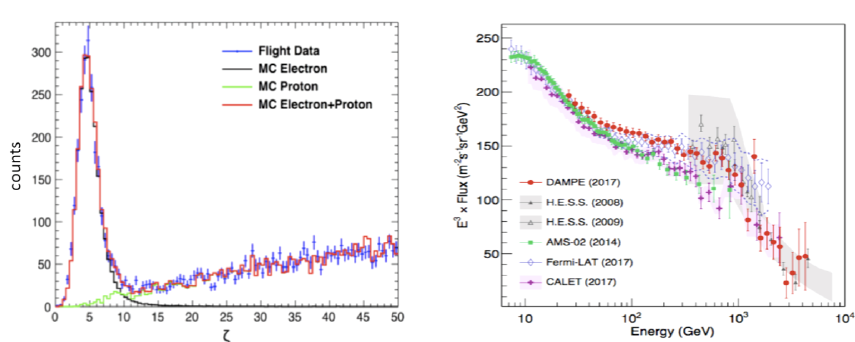
Figure 9. Left: Distribution of the ζ parameter (the cut ζ < 8 . 5 is applied to select the CRE sample). Right: electron and positron spectrum measured by di ff erent experiments (DAMPE: red dots, HESS systematic errors: grey